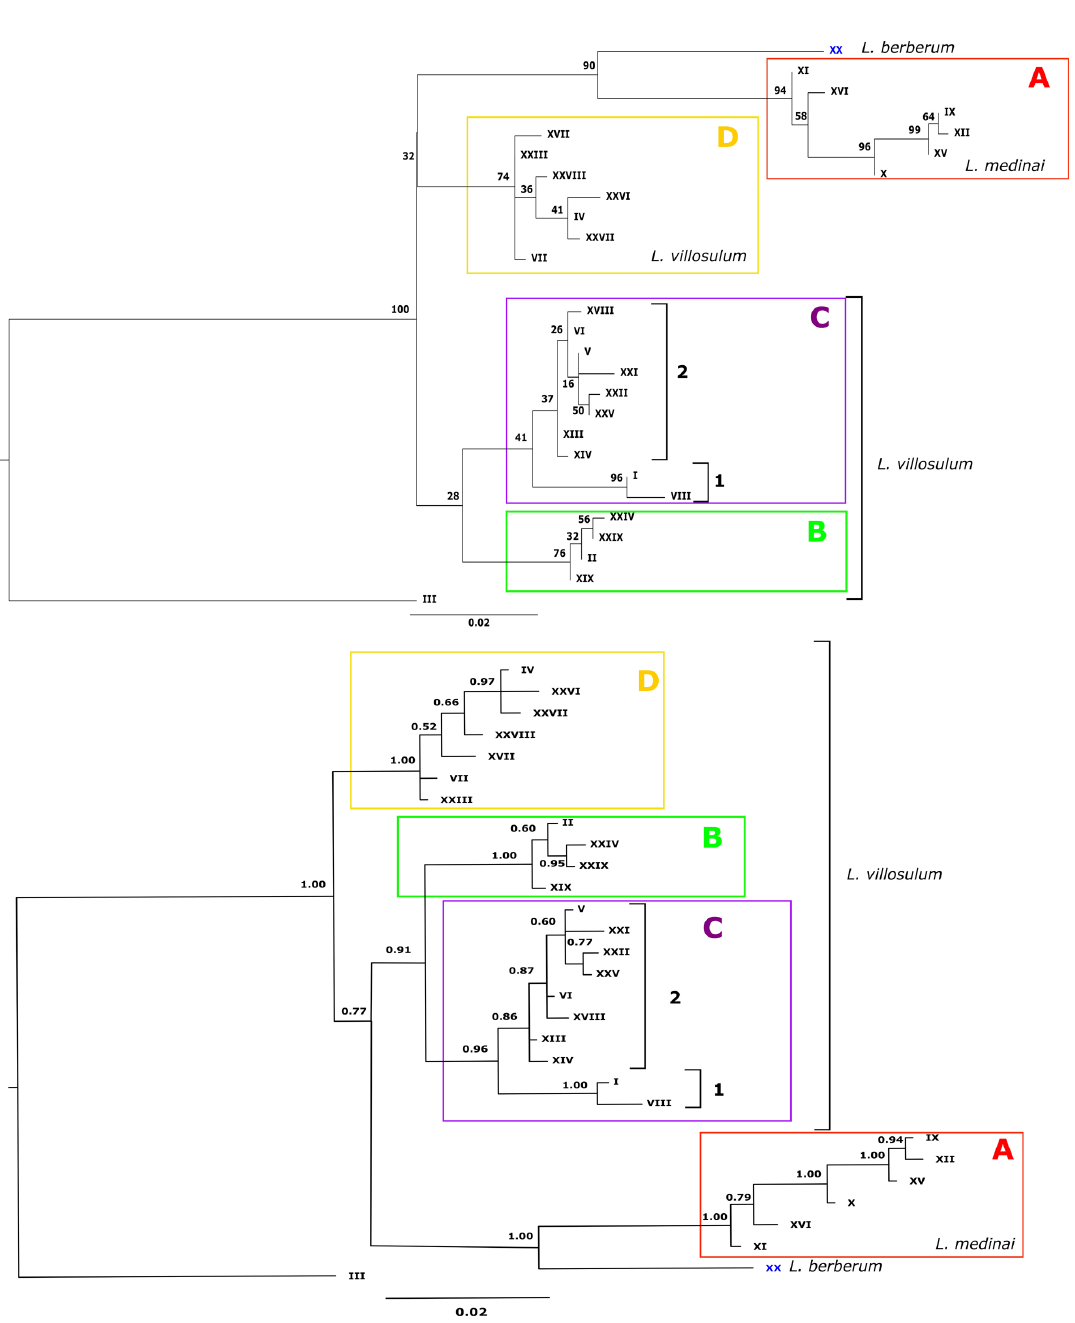
Fig. 3. Trees constructed using maximum likelihood (above) and Bayesian inference (below) and based on 29 haplotype sequences (658bp) of the cytochrome oxidase c subunit I gene of specimens currently identified as Lasioglossum villosulum (Kirby, 1802) , Lasioglossum medinai (Vachal, 1895) and one as Lasioglossum berberum (Benoist, 1941). Each label corresponds to one roman letter which encompasses all sequences from a haplotype (for more details see Table 3). A, Lasioglossum medinai ; B–D: Lasioglossum villosulum . Label highlighted in blue corresponds to L. berberum . This phylogenetic tree is rooted using Lasioglossum bluethgeni Ebmer, 1971 as outgroup (label III, voucher AP222). Bootstrap support (%) and posterior probabilities are given at